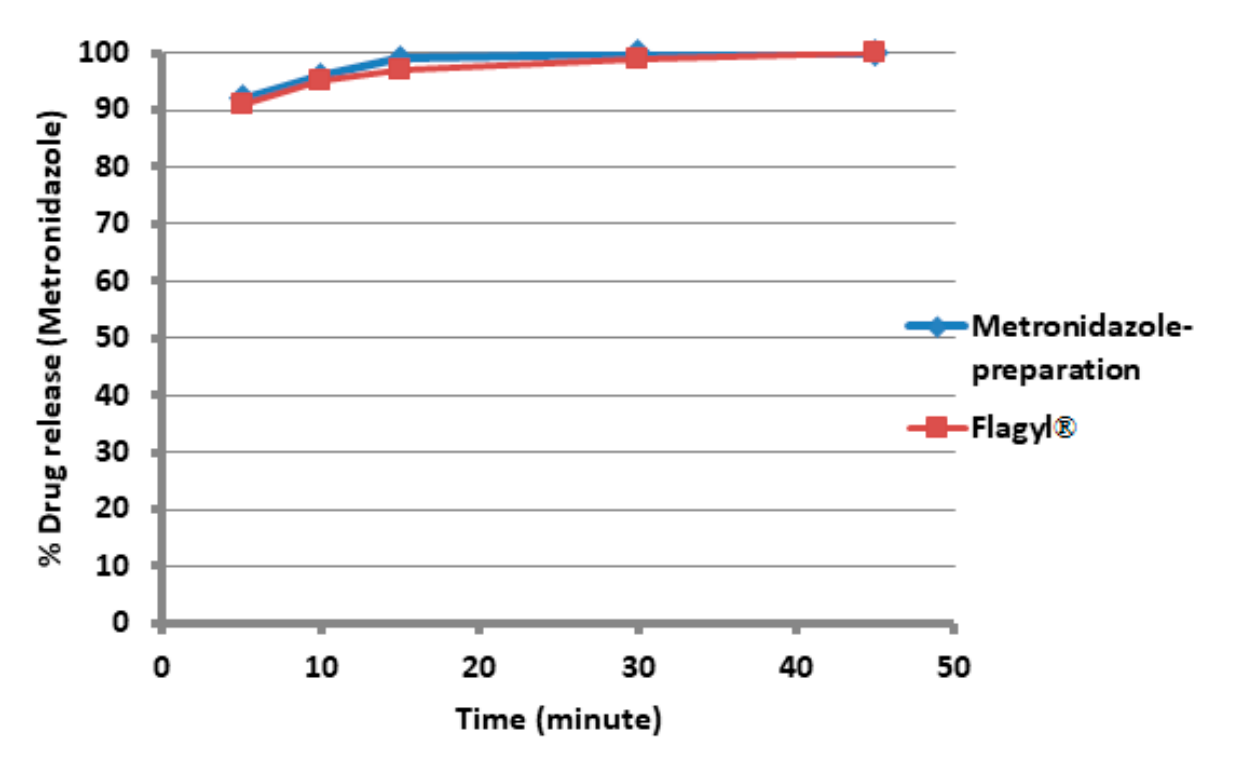
Figure 5. Percent drug release of metronidazole with 60% MCC, 30% starch, and 10% Mg silicate that has been prepared and Flagyl ® . Each point is based on the average of six tablets.